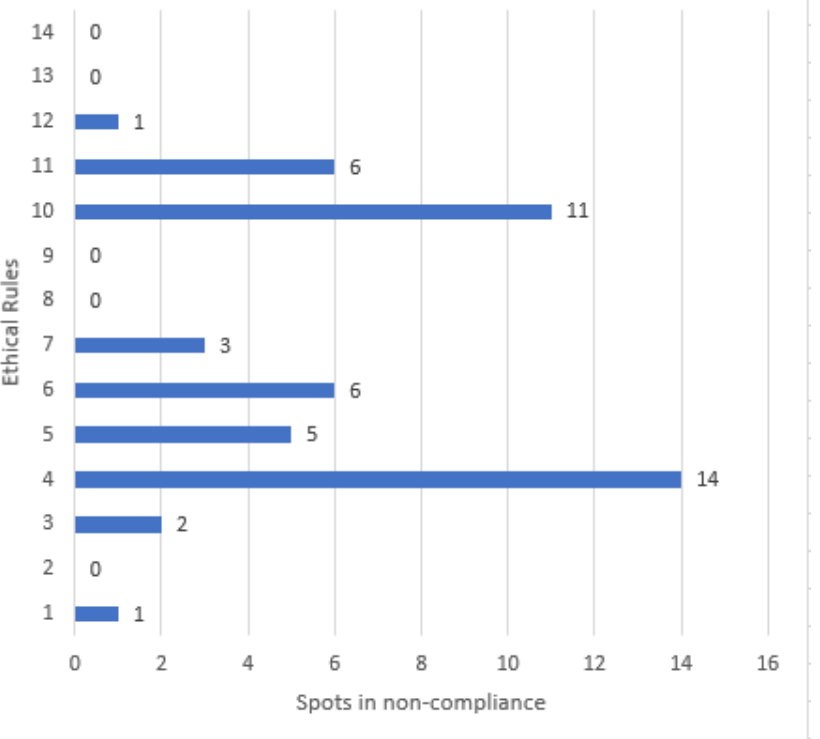
Figure 1. Noncompliance with general ethical rules in Food & Beverage Ads (FBA) in Spanish TV in 2020.